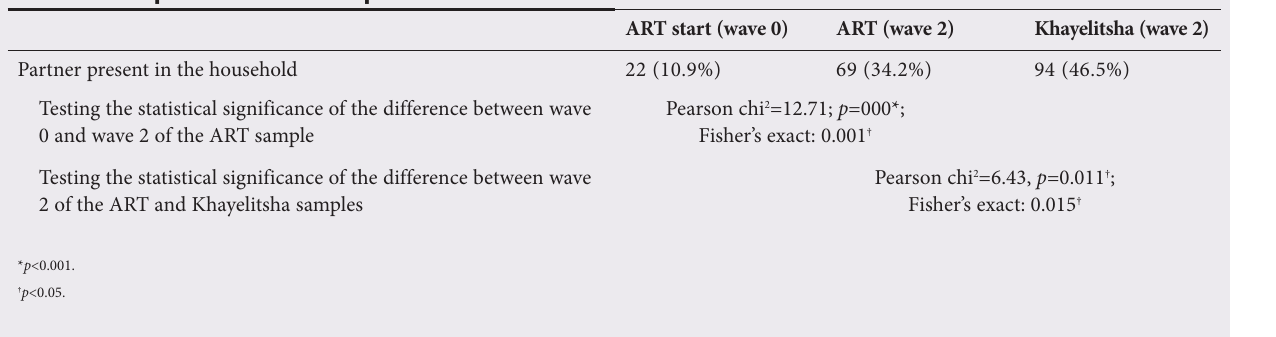
Table 5. The presence of sexual partners in